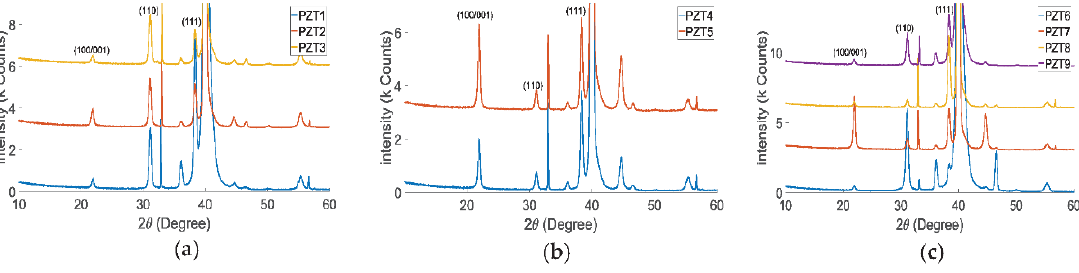
Figure 2 . XRD pattern of samples PZT1 to PZT9 (all samples have less than 400 nm thickness).